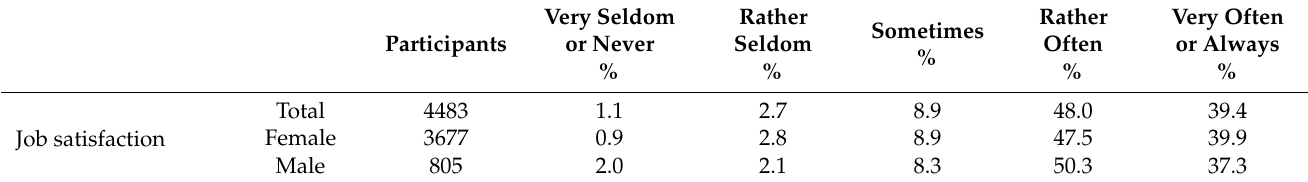
Table 2. Job satisfaction by